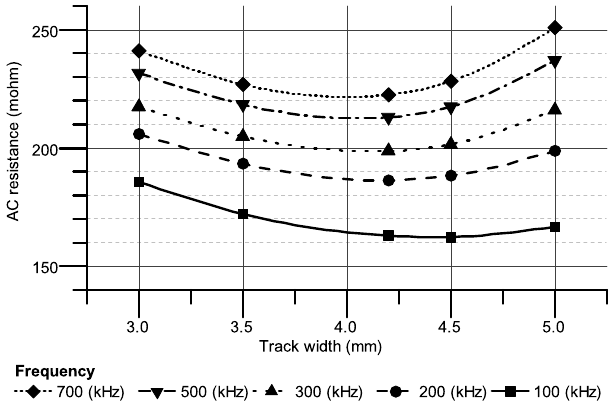
Figure 9. AC resistances of seven-turn PCB windings.